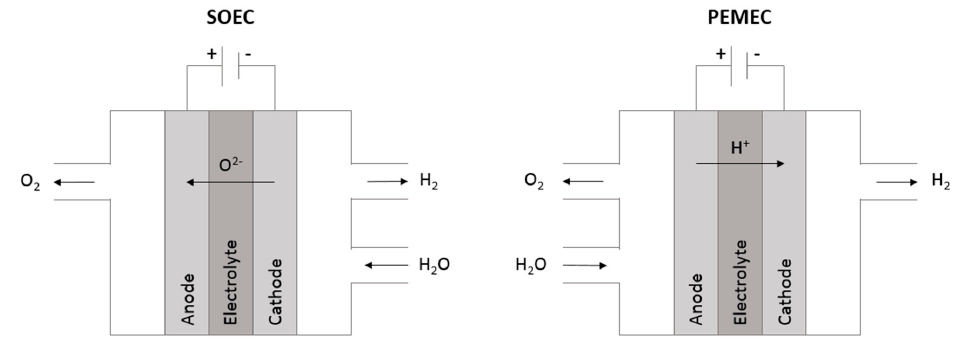
Figure 2. Comparative schematics of a polymer exchange membrane electrolysis cell (PEMEC) and a solid oxide electrolysis cell (SOEC) (Based on schematics from [15]). solid oxide electrolysis cell (SOEC) (Based on schematics from